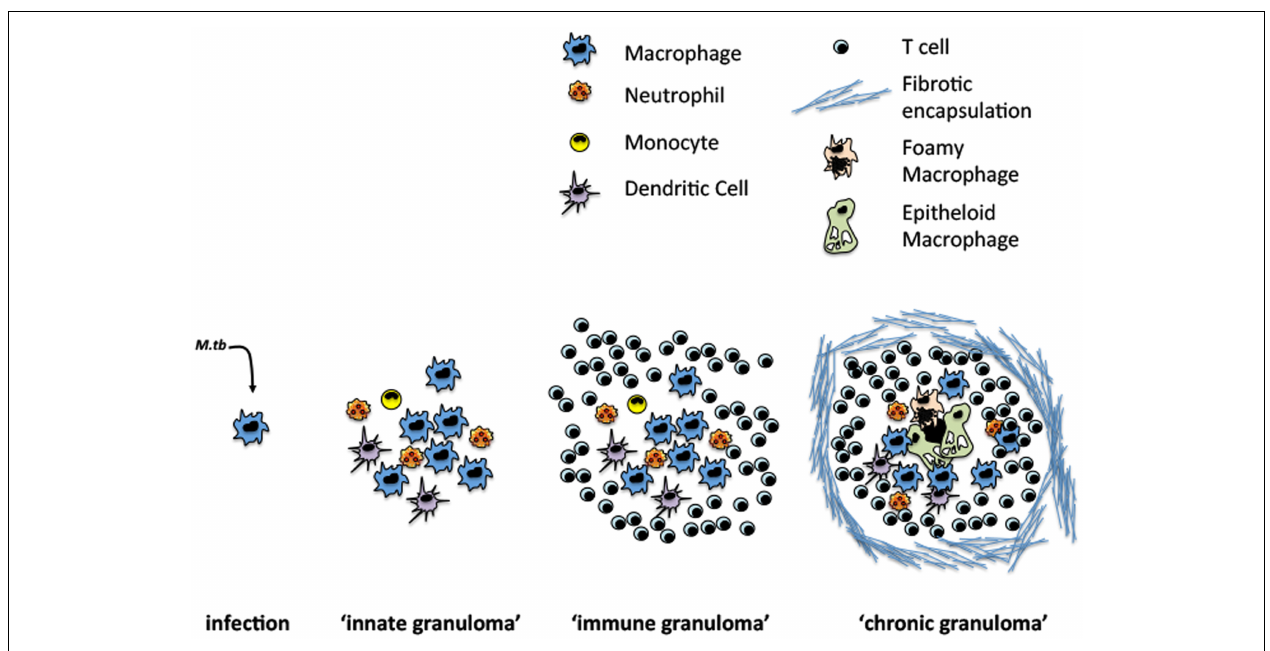
FIGURE 1 | Evolution ofTB granuloma formation. Following infection sentinel macrophages cells facilitate M.tb uptake and the recruitment of other innate and adaptive immune